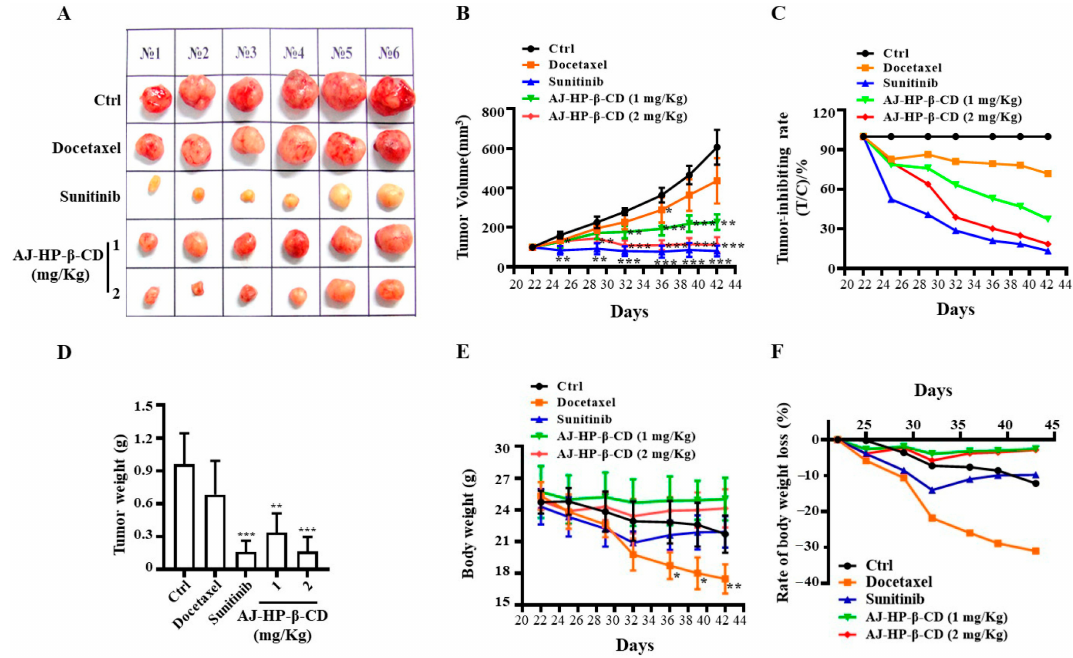
Figure 6. E ff ect of AJ-HP- β -CD on 786-O tumor growth in nude mice. Tumor diameter ( A ) was measured with a Vernier caliper, and the relative tumor volume ( B ) and tumor inhibition rate ( C ) were calculated. Tumor weight ( D ) and body weight ( E ) were measured, and the rate of body weight loss ( F ) was calculated. * p < 0.05, ** p < 0.01, and *** p < 0.005 compared with the control group, B and E statistical analysis was calculated using two-way ANOVA with Tukey’s post hoc test ( n = 6), ( A , C , F ) ( n = 6), ( D ) statistical analysis was calculated using student’s t -test ( n =